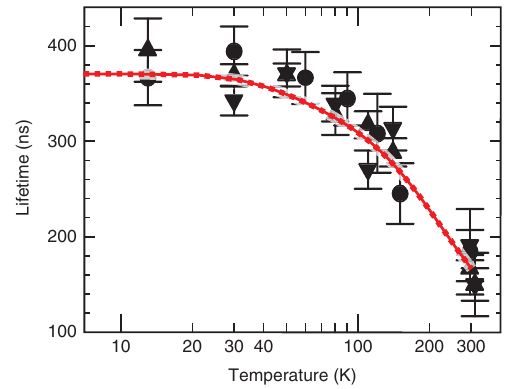
Figure 12: The calculated lifetime [177] of the singlet shelving state is plotted as a function of the temperature with the observed lifetimes for two single NV centers (dot and triangle data points with uncertainties) taken from Ref.